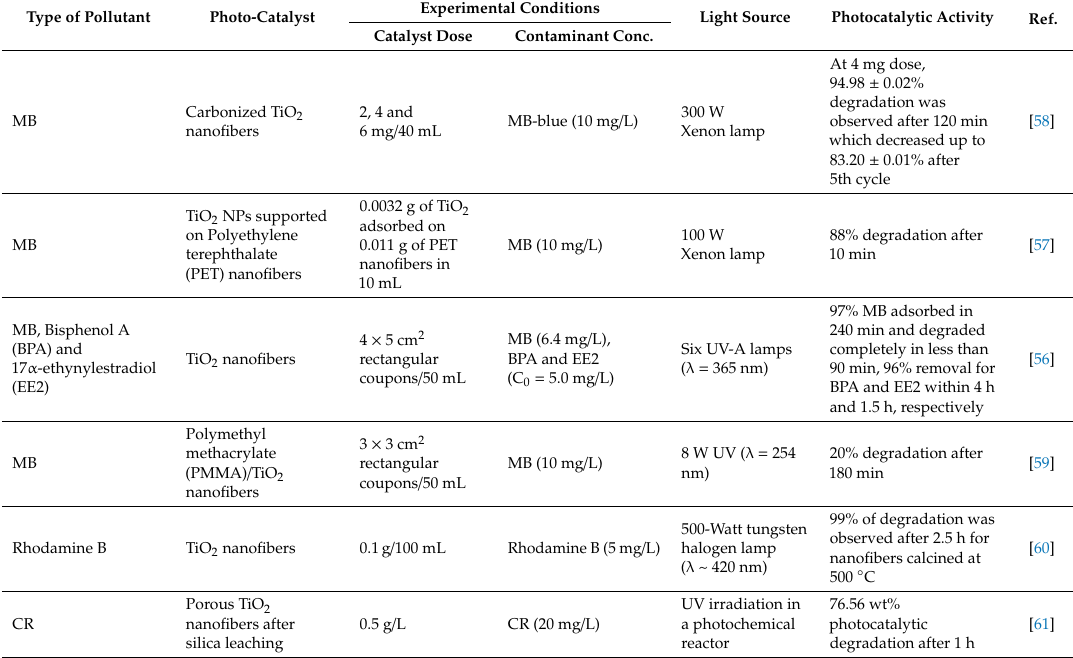
Table 3. Overview of various types of pollutants and TiO 2 based nanofiber photocatalysts employed for wastewater